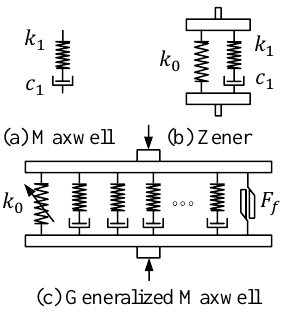
Figure 3. The schematic diagram of rubber